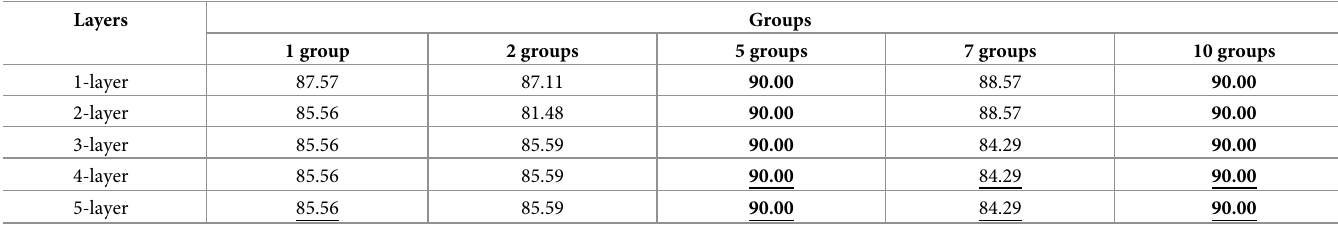
Table 10. Classification performance(%) at each layer where the sunflower-101 class is positive.